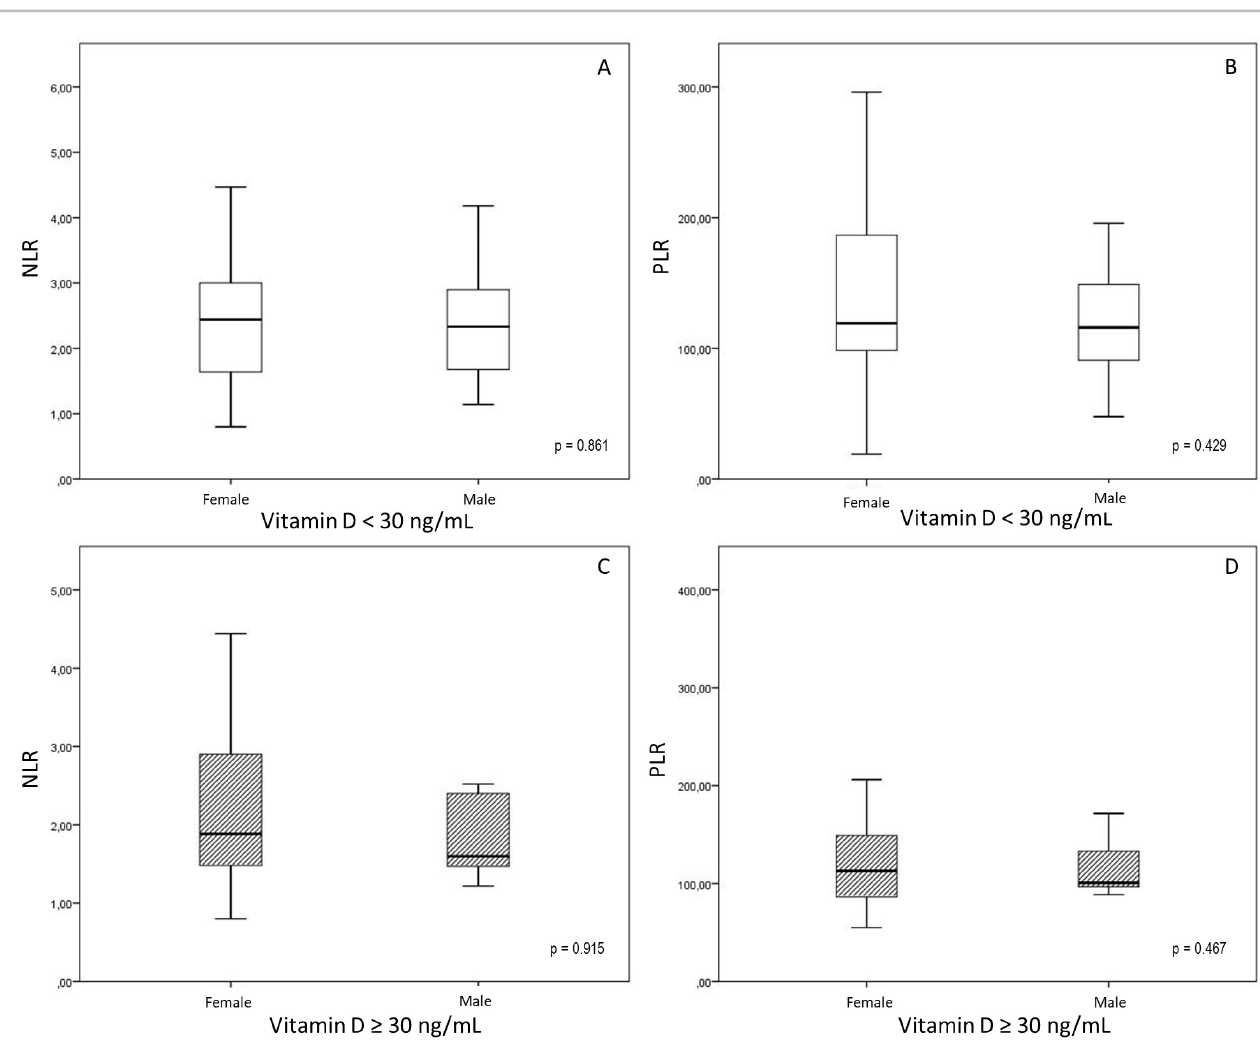
FIGURE 2 - Neutrophil to lymphocyte ratio and platelet to lymphocyte ratio; distributed by gender in individuals in the presence and absence of hypovitaminosis D. NLR, neutrophil to lymphocyte ratio; PLR, platelet to lymphocyte